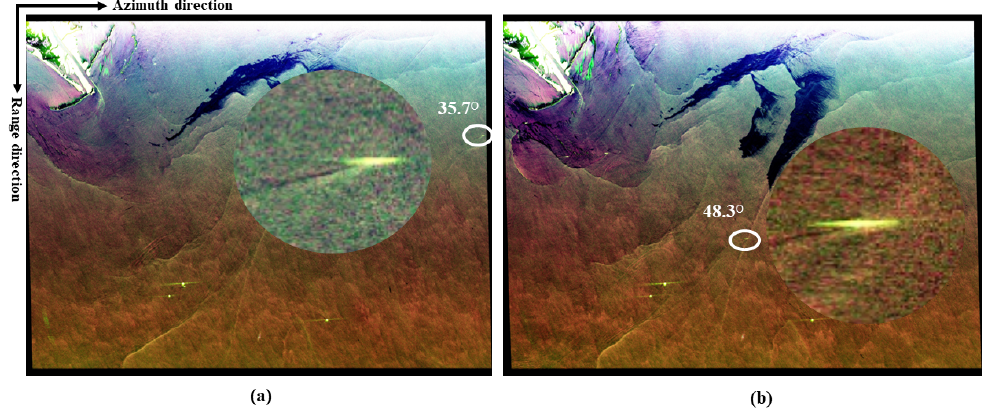
Figure 5. False colour Pauli image related to the UAVSAR scenes collected at the: ( a ) lowest and ( b ) highest AOI. The fishing trawler under investigation, enclosed in the white ellipse, is highlighted in the zoomed-in version of the